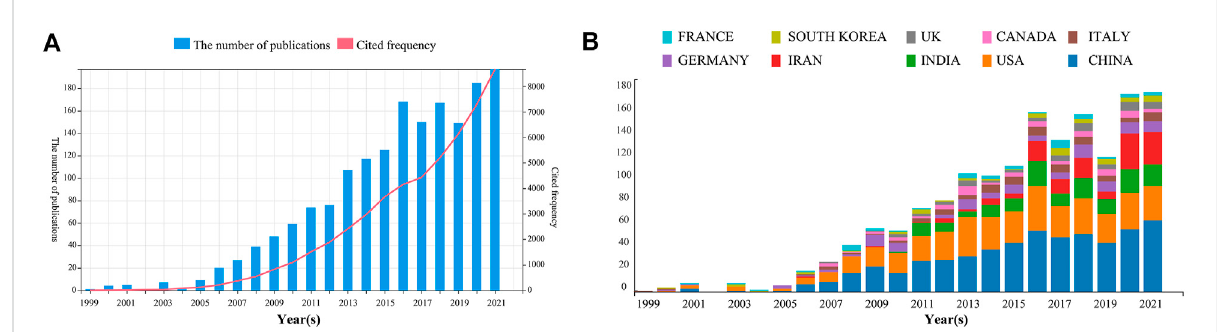
FIGURE 2 (A) Annual publication number and citation frequency ofNanoparticles-leukemia-related studies. (B) Composition ratio ofthe top10 countries by the publication number.